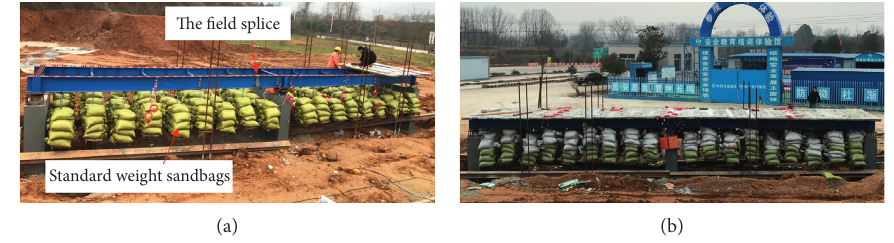
Figure 3: Gravity compensation: (a) gravity compensation of steel girder and (b) gravity compensation of concrete slab.